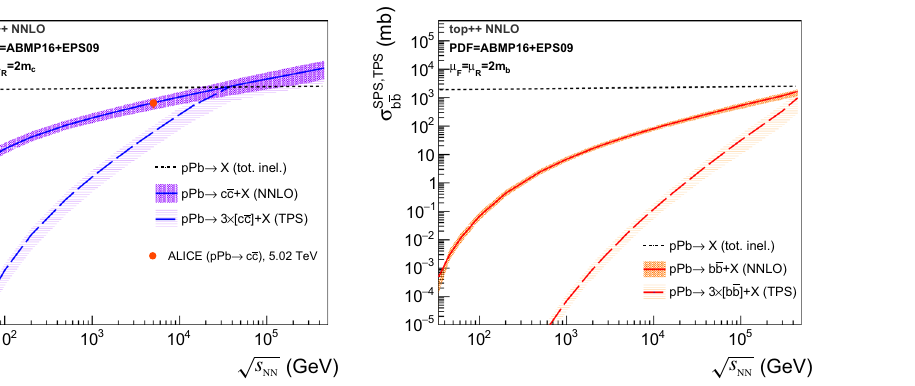
indicate scale, PDF (and σ eff , tps , in the TPS case) uncertainties added in quadrature. The pPb → cc + X charm data point on the left plot has been derived from [42]